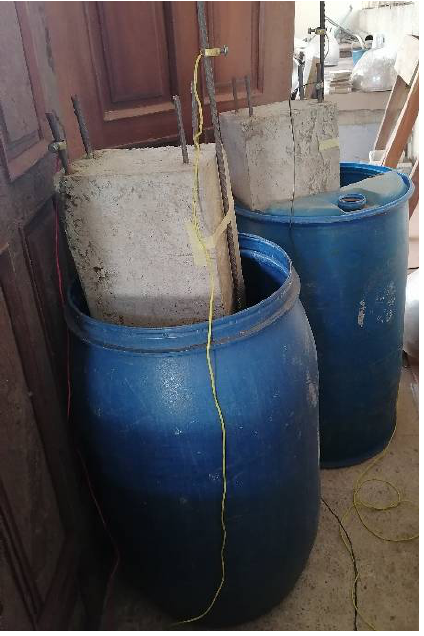
Figure 5. Simulated corrosion set-up in the laboratory.